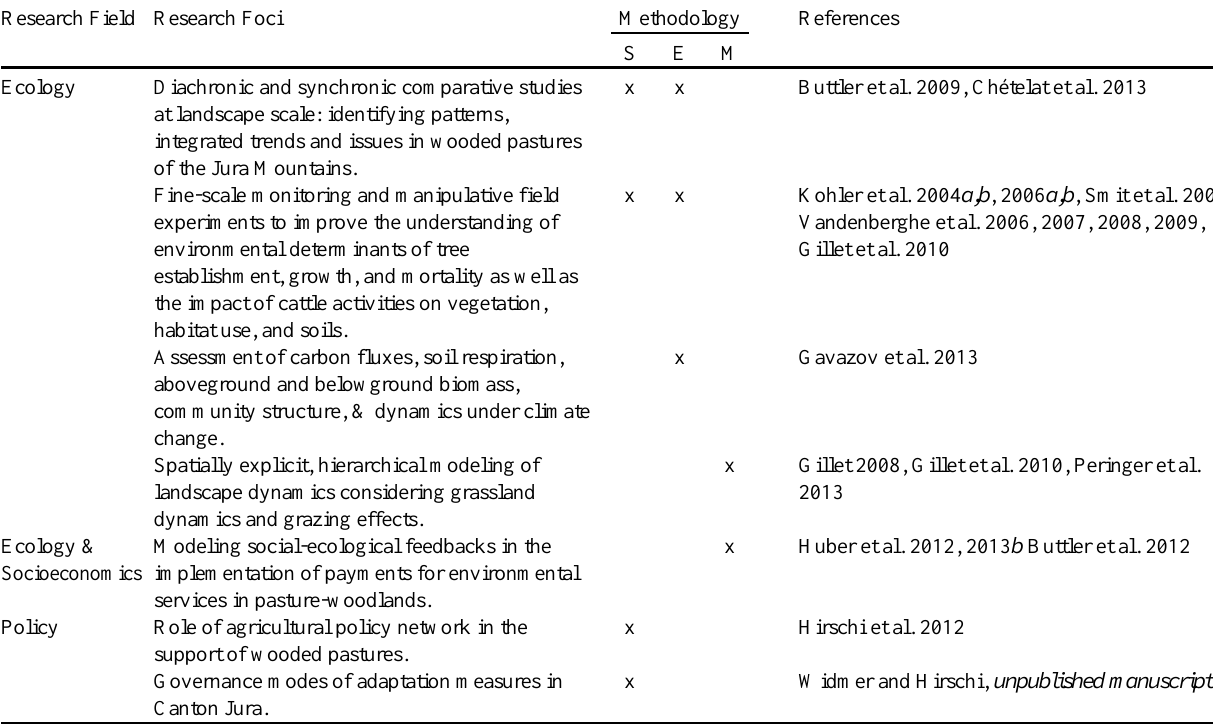
Table 1 . Research foci and methodologies in the wooded pastures of the Jura